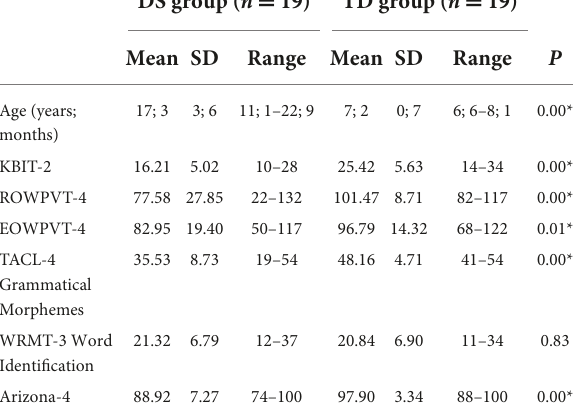
TABLE 2 Participant characteristics in raw scores, standard deviations, and ranges.